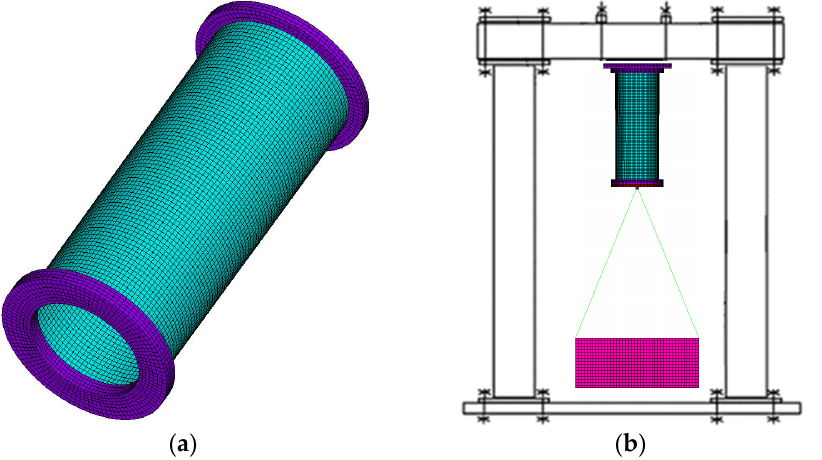
Figure 3. ( a ) Finite element model of manufactured composite cylinder; ( b ) conditions of full-scale experiment.